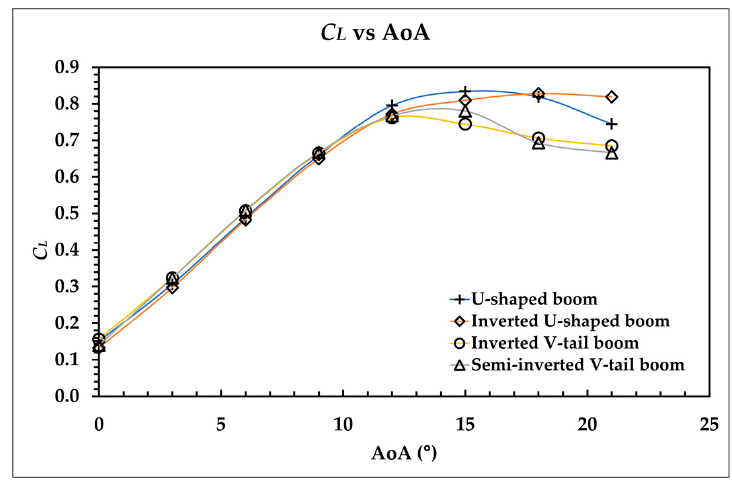
Figure 10. C L vs. AoA headwind conditions.